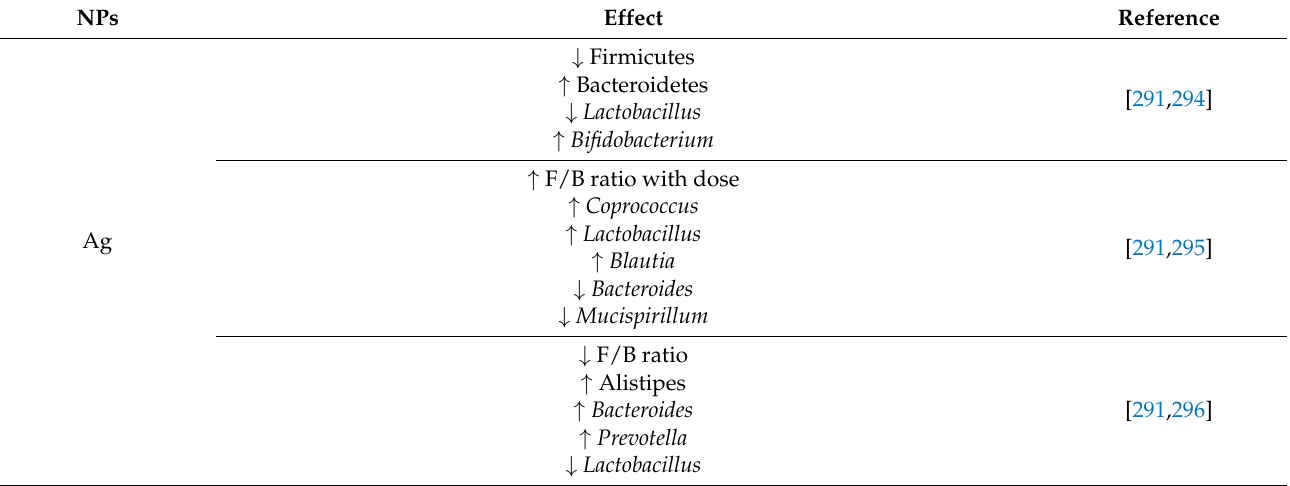
Table 5. The influence of NPs such as Ag, TiO 2 and ZnO on the intestinal microbiota. Abbreviations: Ag, silver; TiO 2 , titanium dioxide; ZnO, zinc oxide; F/B, Firmicutes/Bacteroidetes: ↑ , increased bacteria; ↓ decreased